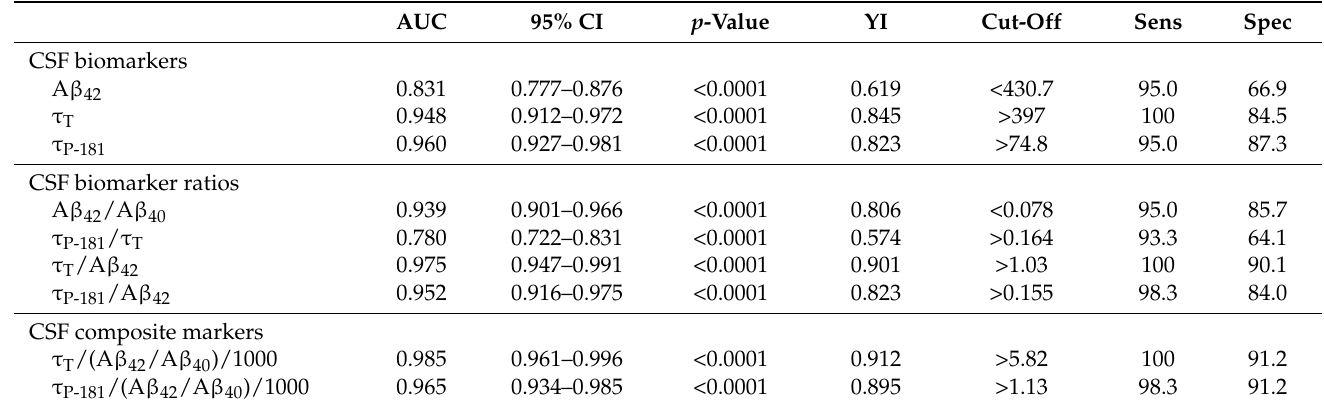
Table 4. ROC curve analysis of the diagnostic accuracy of CSF biomarkers, biomarker ratios, and composite markers in the differentiation of Alzheimer’s disease pathology from non-Alzheimer’s disease pathologies, irrespective of the clinical phenotype. AUC: area under the curve; 95% CI: 95%